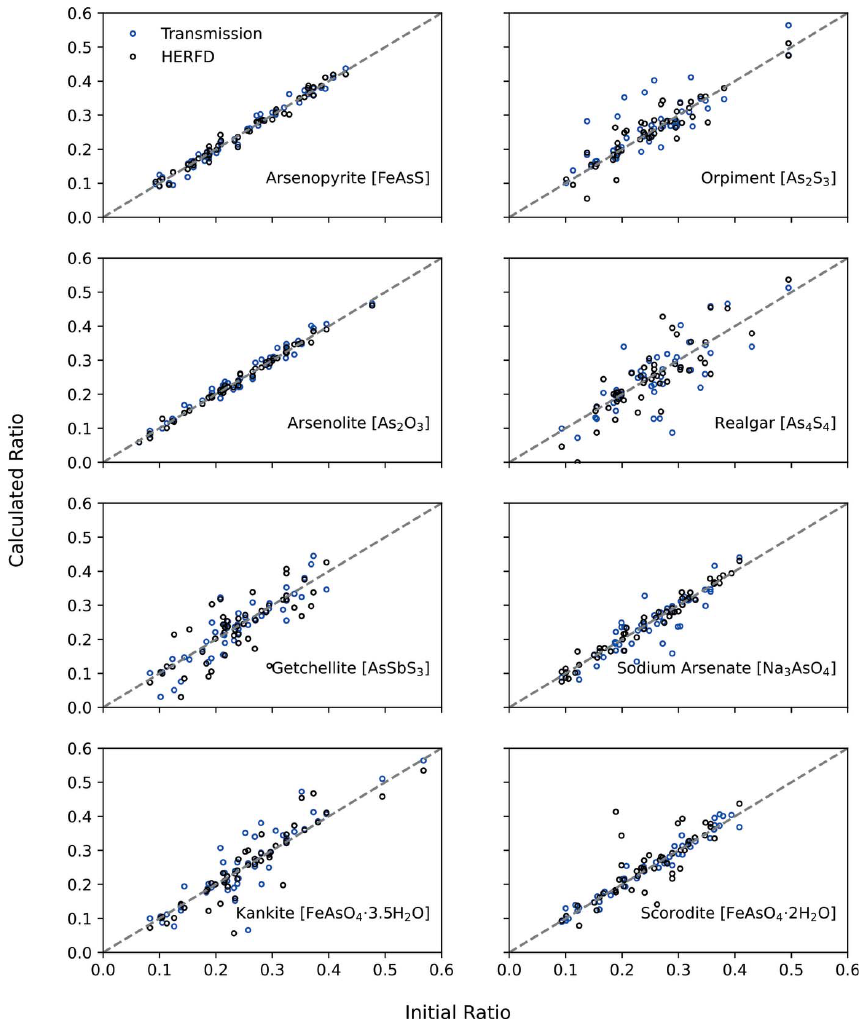
Figure 2 A comparison of the initially generated ratio that was used to create the synthetic standard and the ratio determined from LCF. HERFD results are in black and transmission results are in blue. LCF that perfectly replicated the data would result in points that lie along unity (grey dashed line). Fifty of the total 3500 results were randomly selected for visualization to improve the readability of the